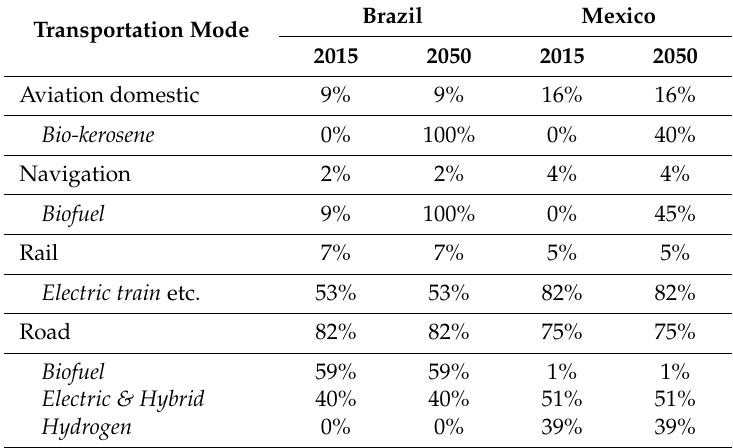
Table 7. Modal & technology shares in final energy for transport in E [R] for 2015 and 2050. Transportation Mode